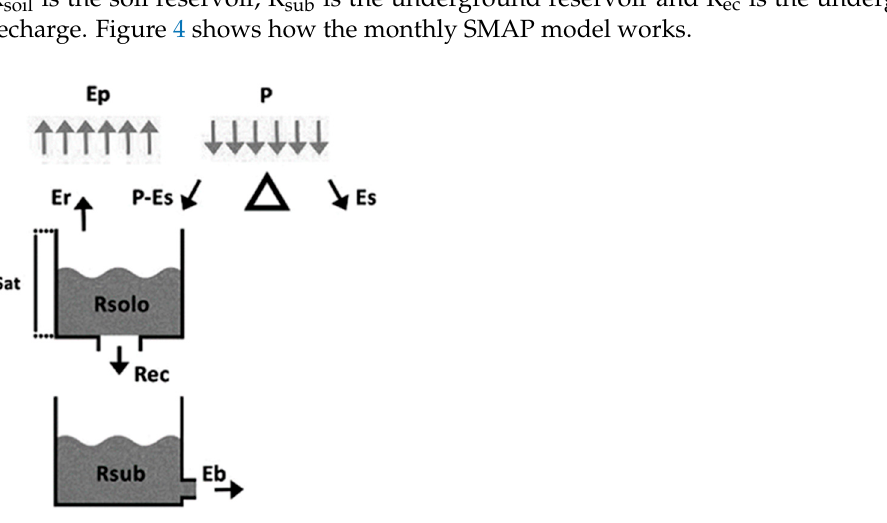
Figure 4. Schematic monthly soil moisture accounting procedure (SMAP) model. Source: [43].